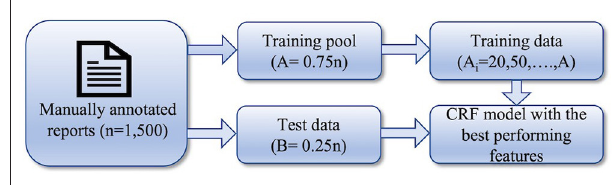
FIGURE 2 | Workflow of the 2nd stage of the experiment: determining the minimum size of training set.